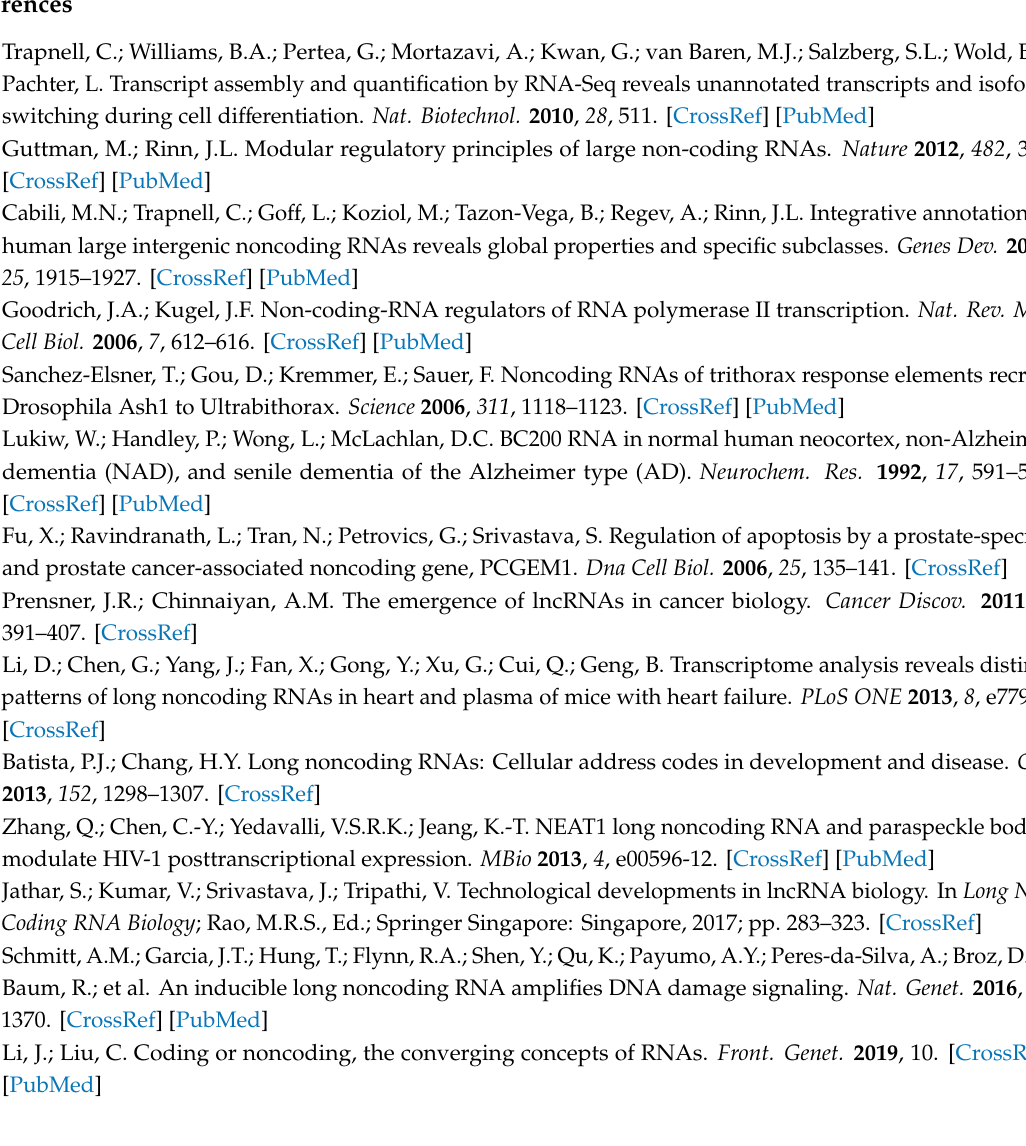
Figure S1: The importance scores of features in the intersection of optimal subsets for both human, Table S1: The download links of datasets we used, Table S2: The intersections of optimal feature subsets for human and mouse, Table S3: The performance of PredLnc-GFStack on the list of well-known